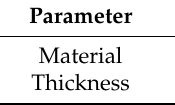
Table 4. Parameters of the magnet.